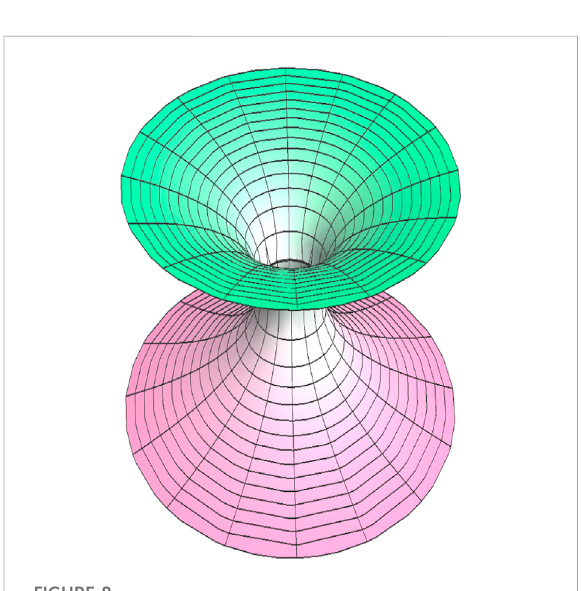
FIGURE 8 Surface revolution of embedding diagram for model